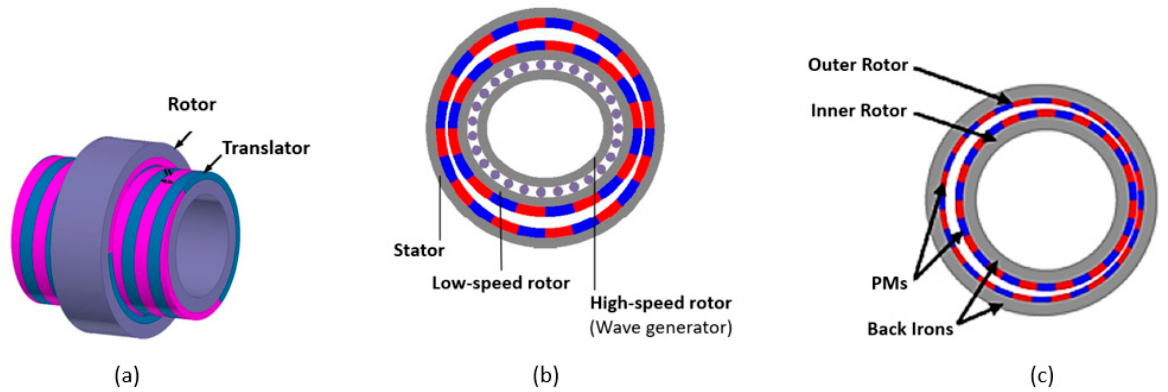
Figure 12. Magnetic gear designs with modulated flux and different from the coaxial concept: ( a ) Trans-Rotatory MG; ( b ) Magnetic Harmonic Gear; ( c ) Cycloidal MG.